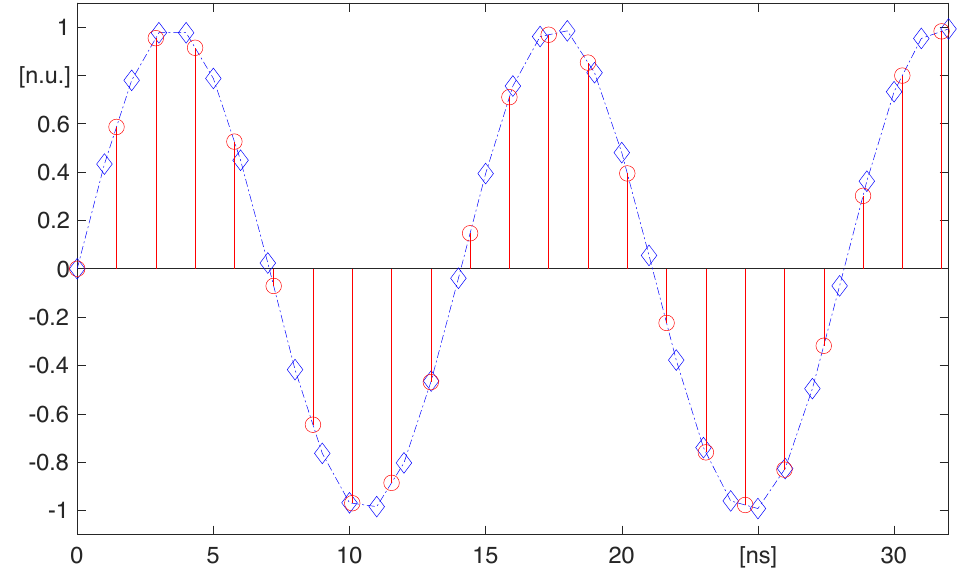
Figure 7. The sinusoidal signal sampled at the 1 GHz (diamond markers) is down-sampled to 693 MHz (circle markers); amplitude values are normalized to the